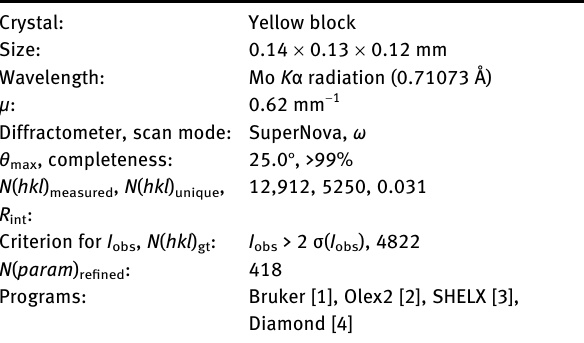
Table  : Data collection and